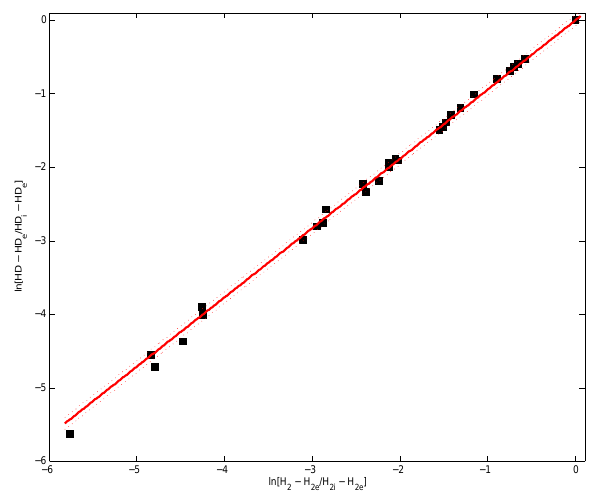
Fig. 3. Aggregate data analysis for the calculation of the mean ki- netic isotope effect based on the equilibrium model from all ex- periments (Eq. 5). Least squares regression of these data, con- sidering errors in both H 2 and HD variables, results in a value of ε =− 57 ± 5‰ ( r 2 = 0 . 9994, 95%